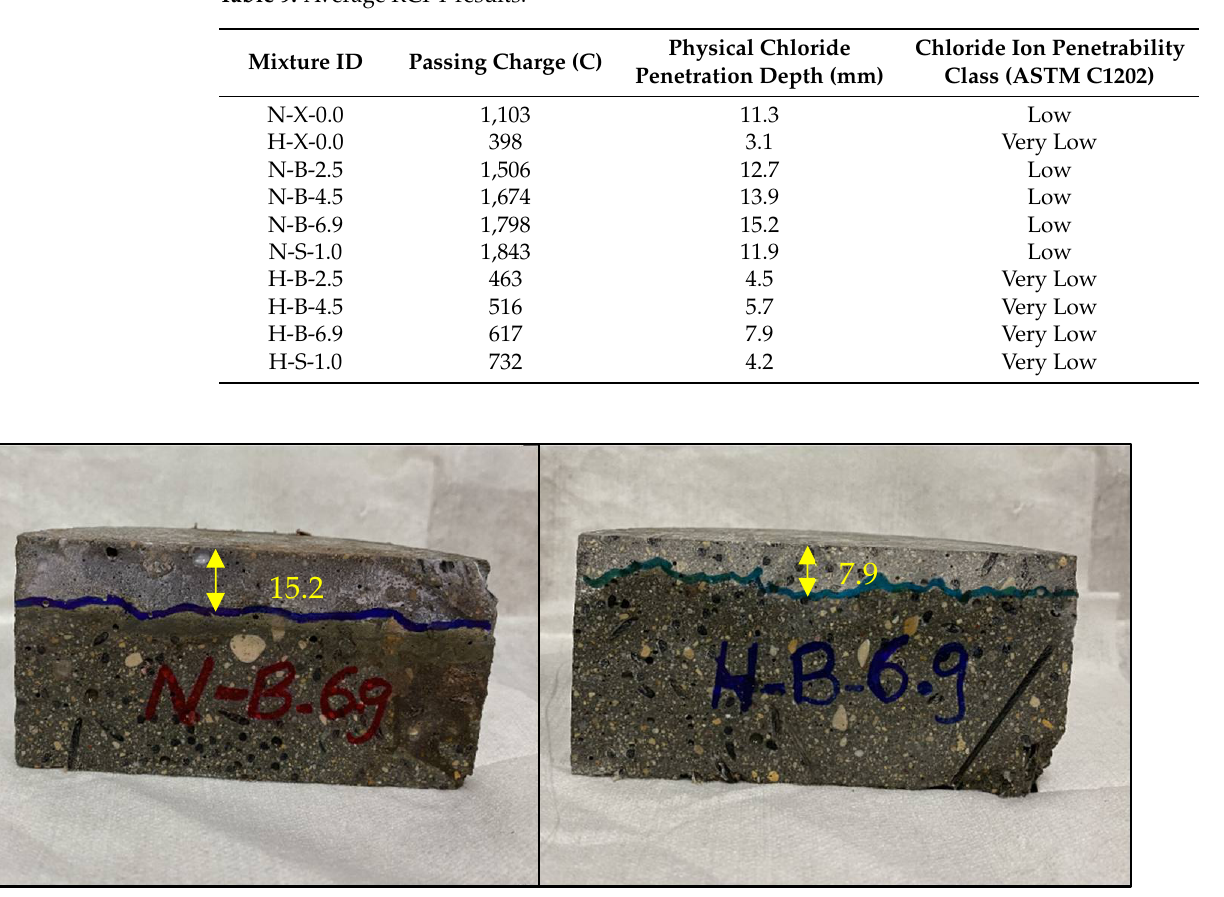
Table 9. Average RCPT results.